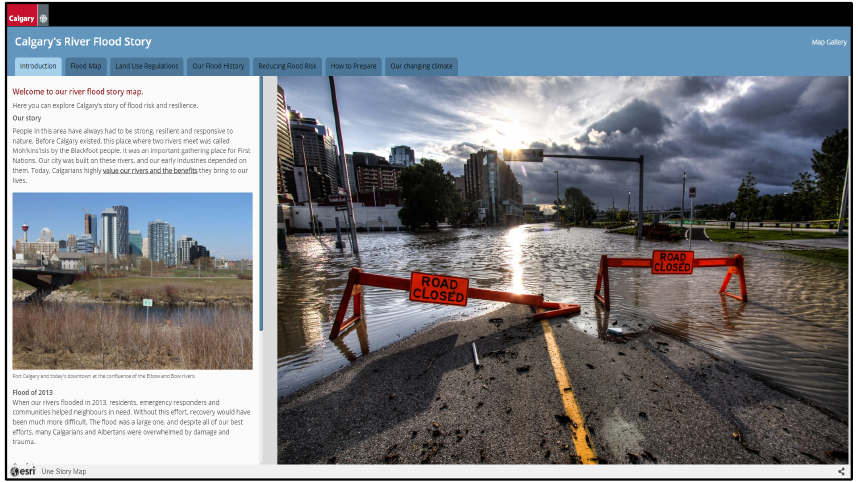
Figure 4. Example of a story map developed with ArcGIS StoryMap Series—Title: Calgary’s River Flood Story